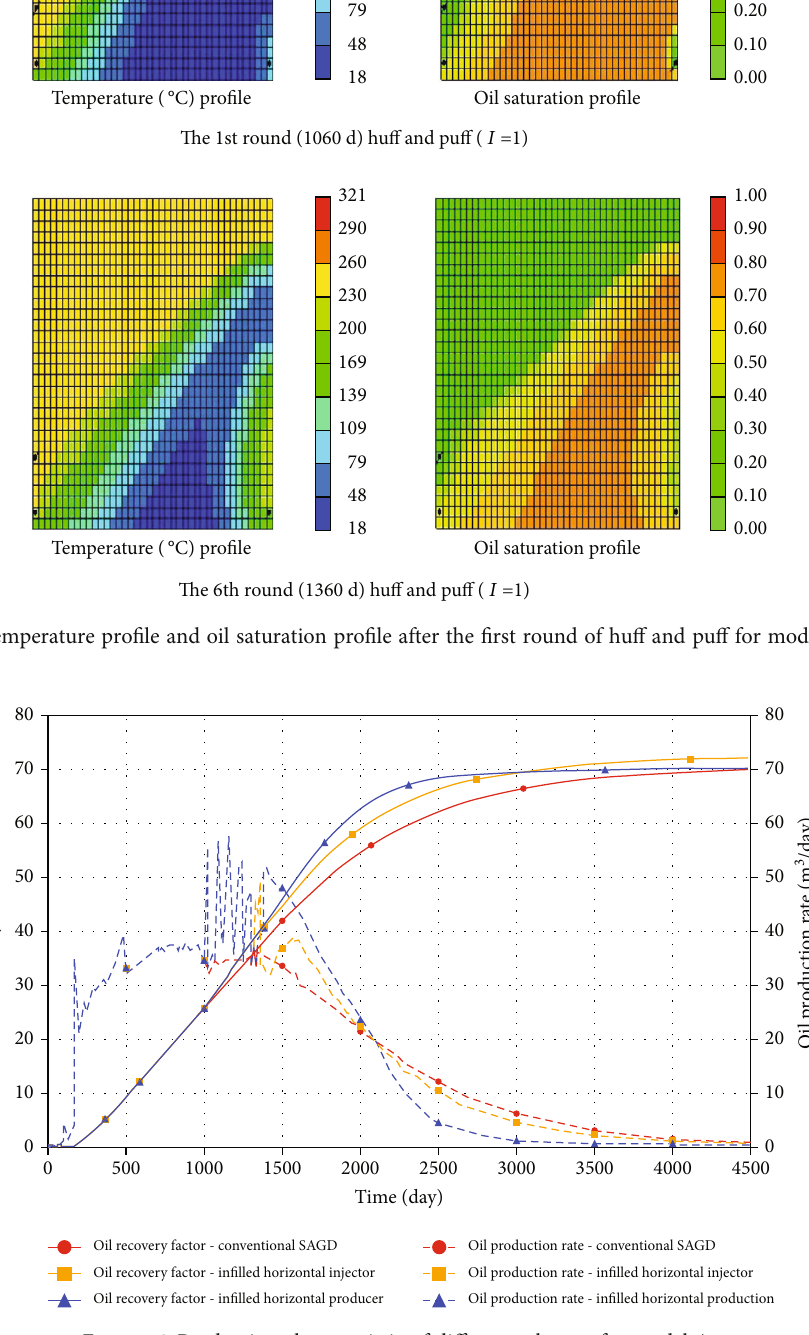
Figure 6: Production characteristic of di ff erent schemes for model